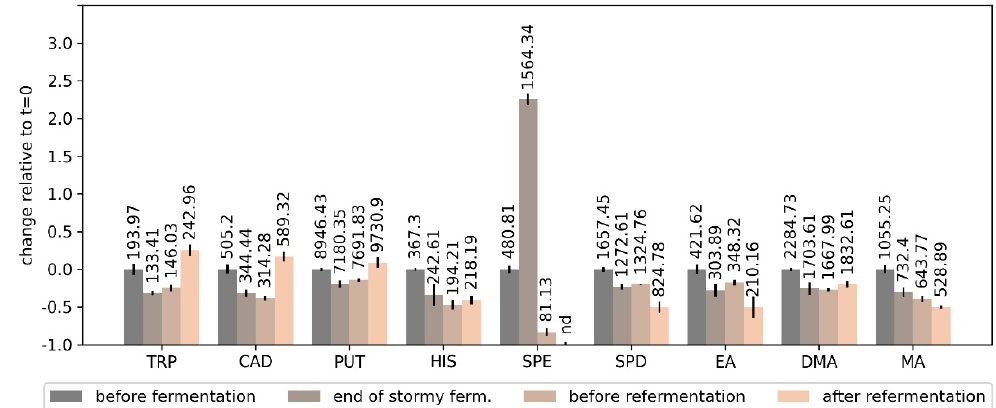
Figure 4. Changes in the concentration of BAs during fermentation of homebrewed ale. Note the logarithmic scale. Shaded areas denote sd ( n = 3).